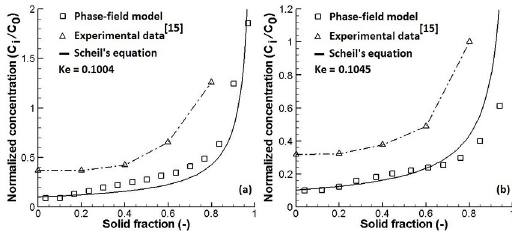
Figure 1: Comparison between experimental microsegregation profiles and predicted by the Scheil's equation and phase-field model: (a) Al–2.64×10 –2 mol%Cu with Ke = 0.1004 and (b) Al–4.5×10 –2 mol%Cu with Ke = 0.1045.